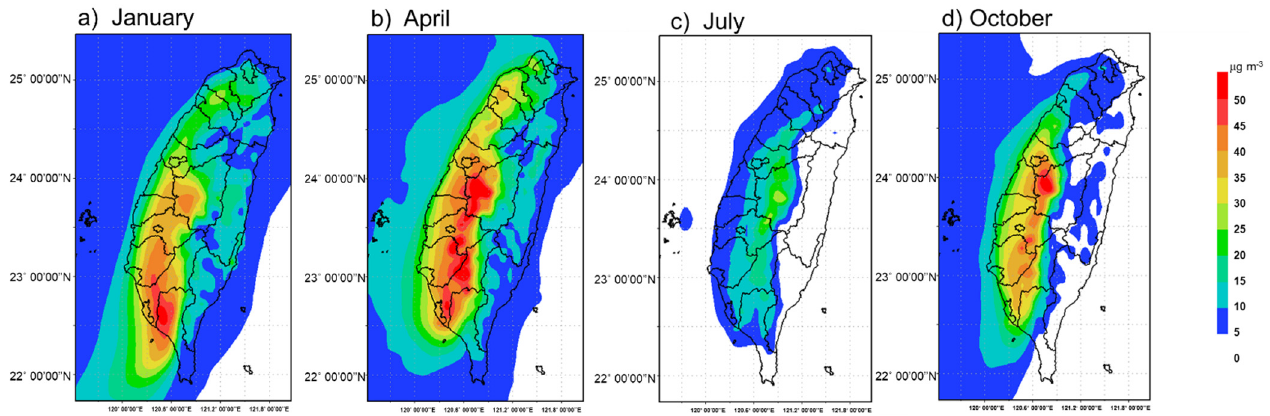
Figure 7. PM 2.5 concentration ( µ g m − 3 ) simulations for January ( a ), April ( b ), July ( c ), and October ( d ) under baseline year conditions.